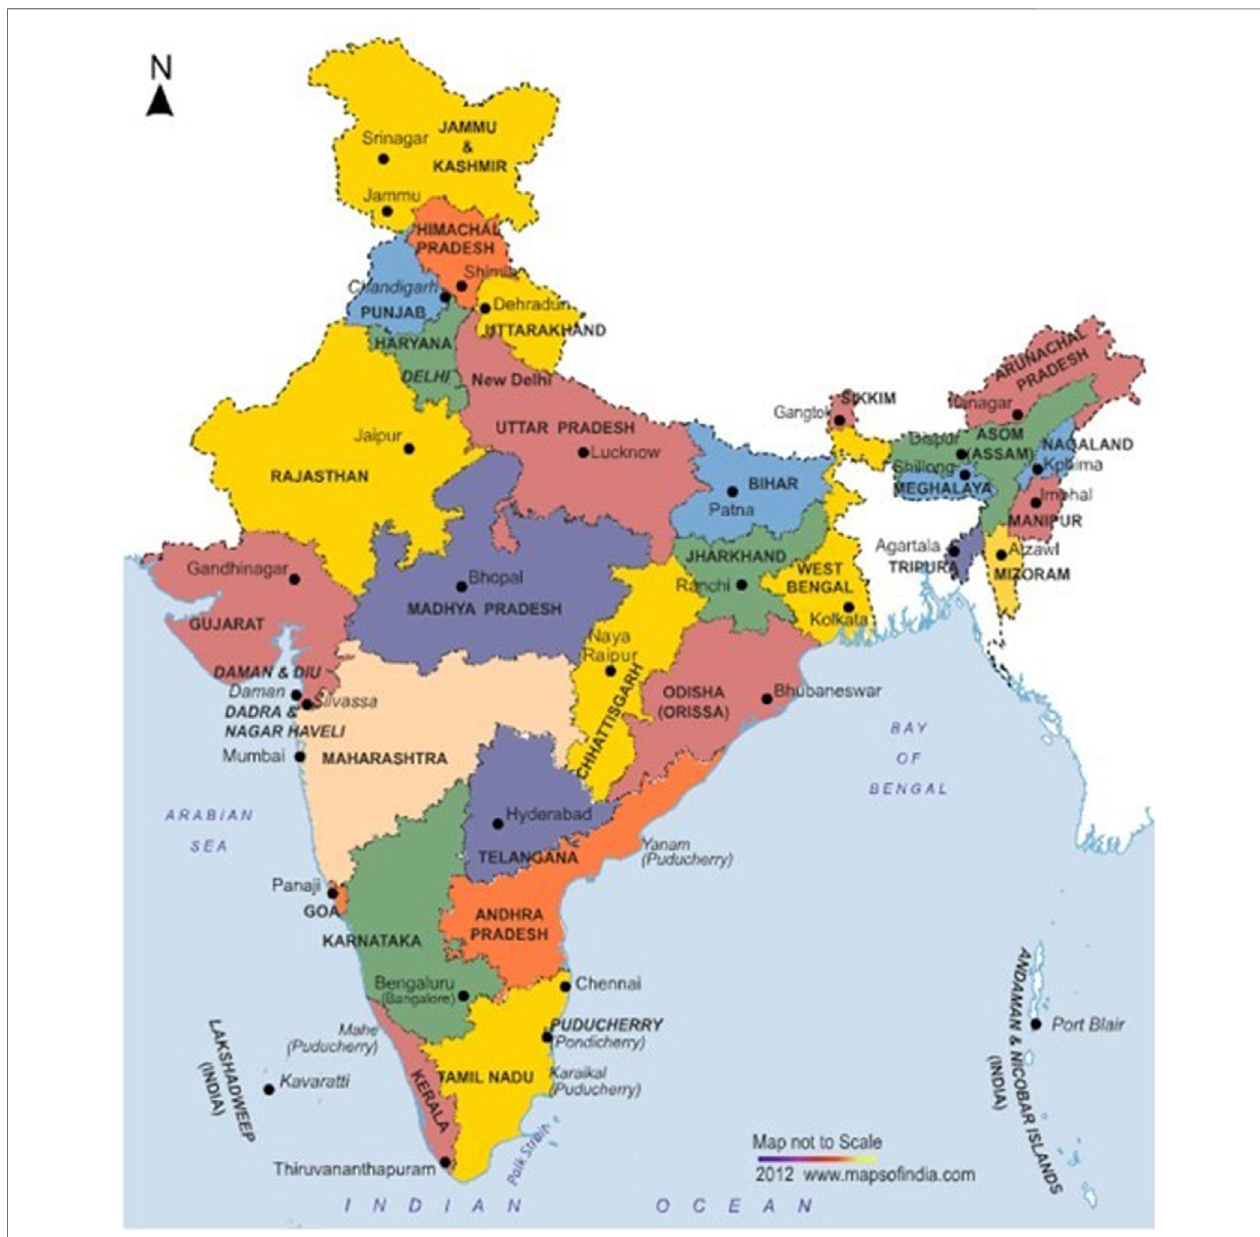
FIGURE 1 | Location map of Tamil Nadu State. Source: Maps of India.